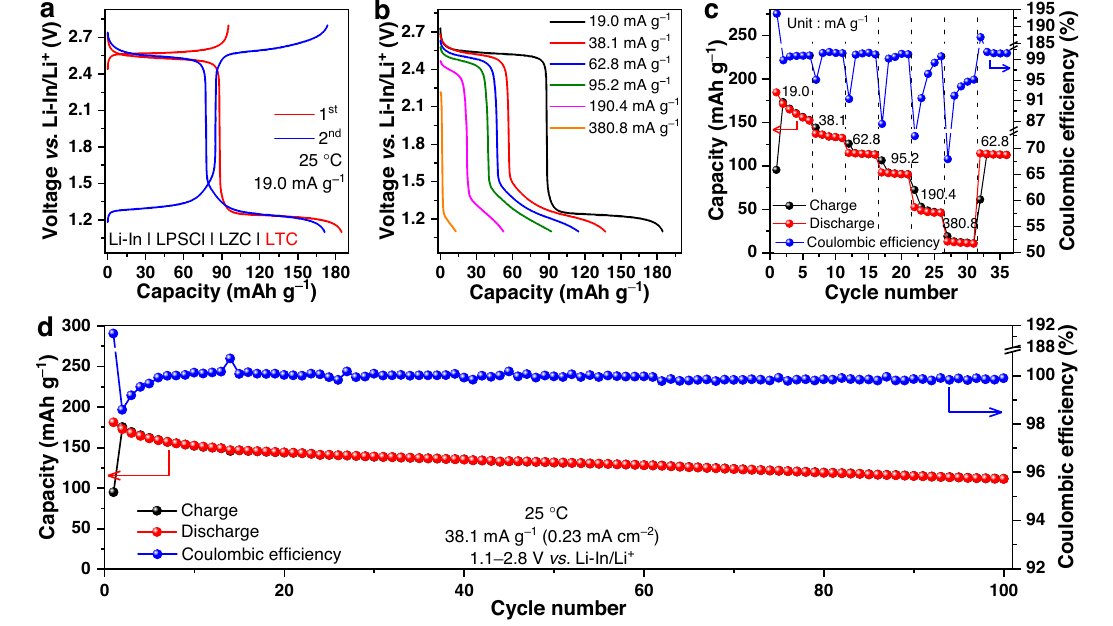
Fig.5|ElectrochemicalperformanceoftheLi-In|LPSCl|LZC|LTCcellbasedon both the Ti 2+ /Ti 3+ and Ti 3+ /Ti 4+ redox couples. a The charge/discharge curves of the fi rsttwocyclesunder19.0mAg − 1 at25°C. b , c Ratecapabilityat19.0,38.1,62.8,